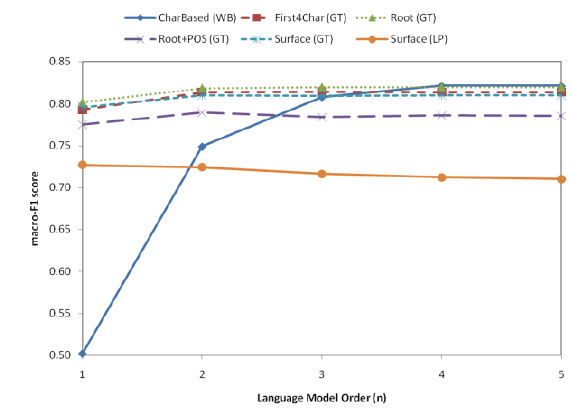
Fig. 8. Performance comparison of proposed language model types with best performing smoothing